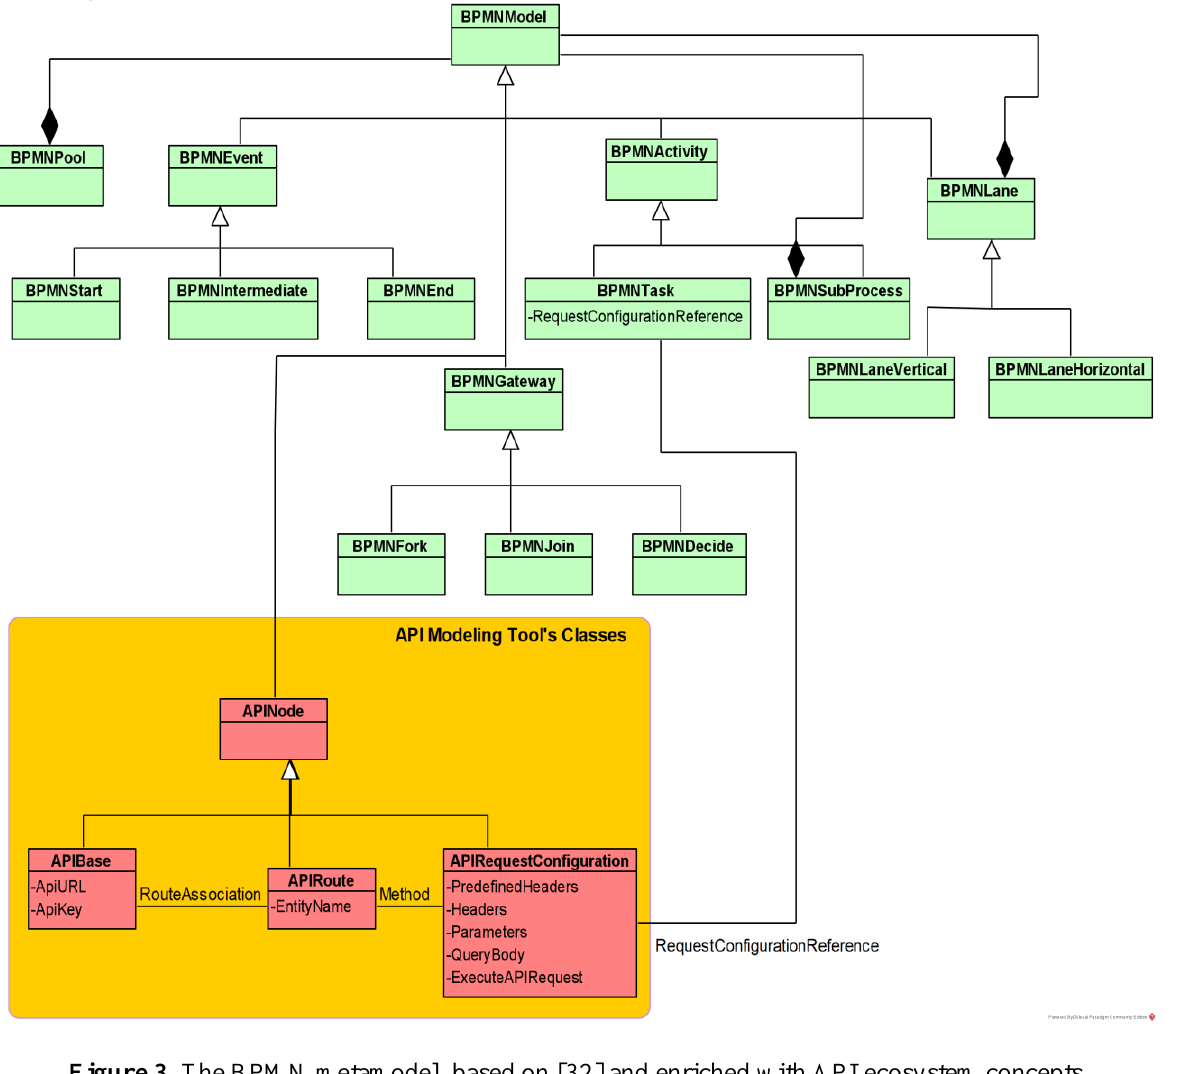
Figure 3. The BPMN metamodel, based on [32] and enriched with API ecosystem